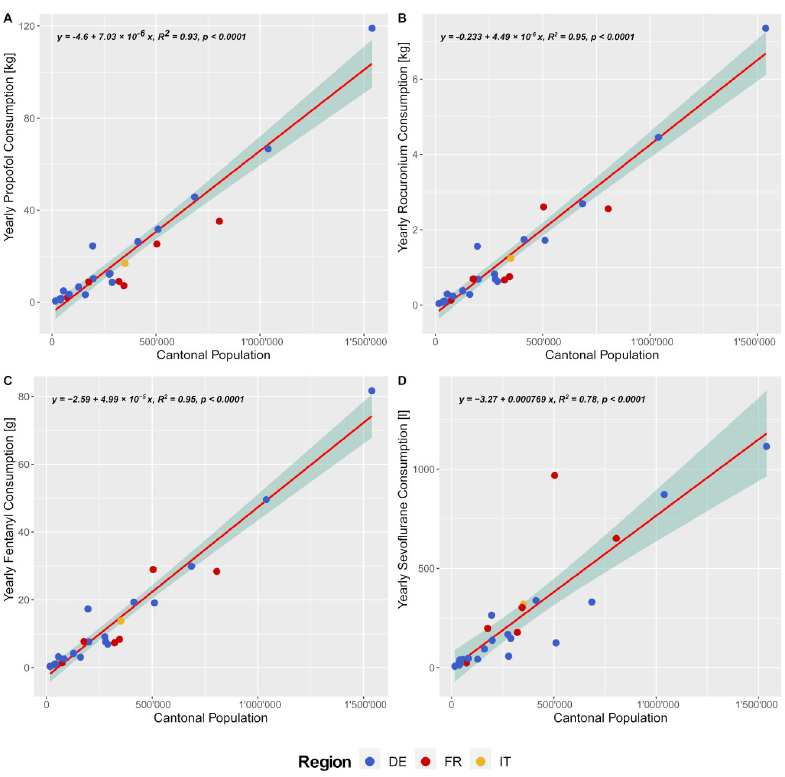
Fig 3. Swiss annual anaesthetic consumption per cantonal population size and language region. The annual consumption is exemplified for the following anaesthetics: A) Propofol, B) Rocuronium, C) Fentanyl, D) Sevoflurane. The sub-plots for each anaesthetic present the yearly consumption of anaesthetics per size of the cantonal population (dots), sub-stratified by language region DE–German region (blue), FR–French region (red) and IT–Italian (yellow) region. Further, the fitted linear regression (red line) is displayed with its standard error (turquoise shaded area) and the corresponding linear equation, with R 2 - and p -values are shown on the left upper corner of each